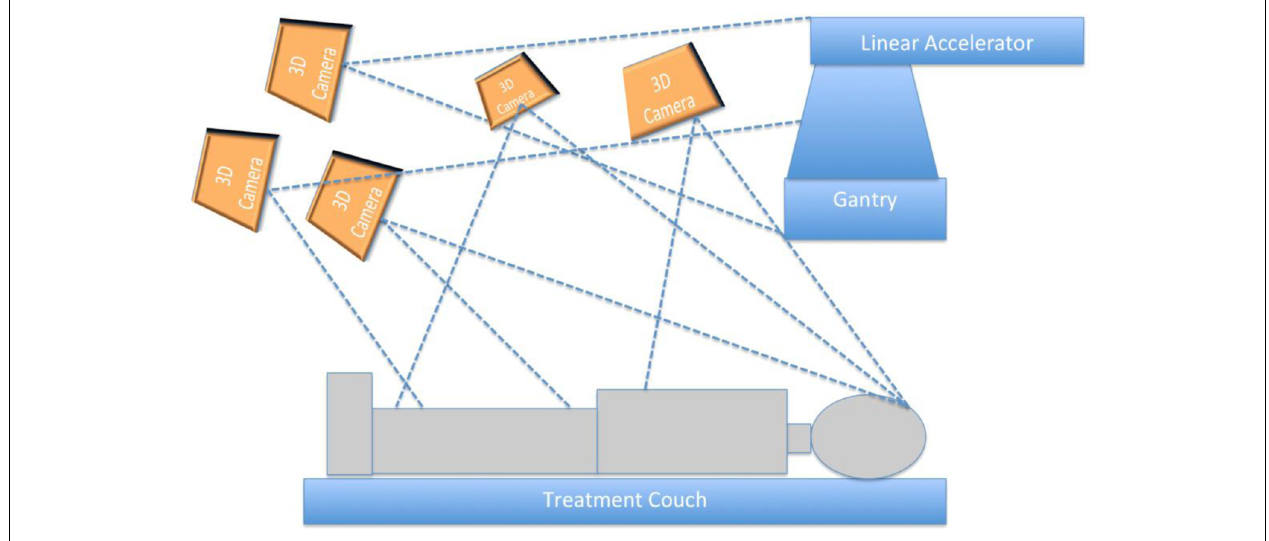
FIGURE 1 |A schematic representation of the camera setup for head and neck radiotherapy.